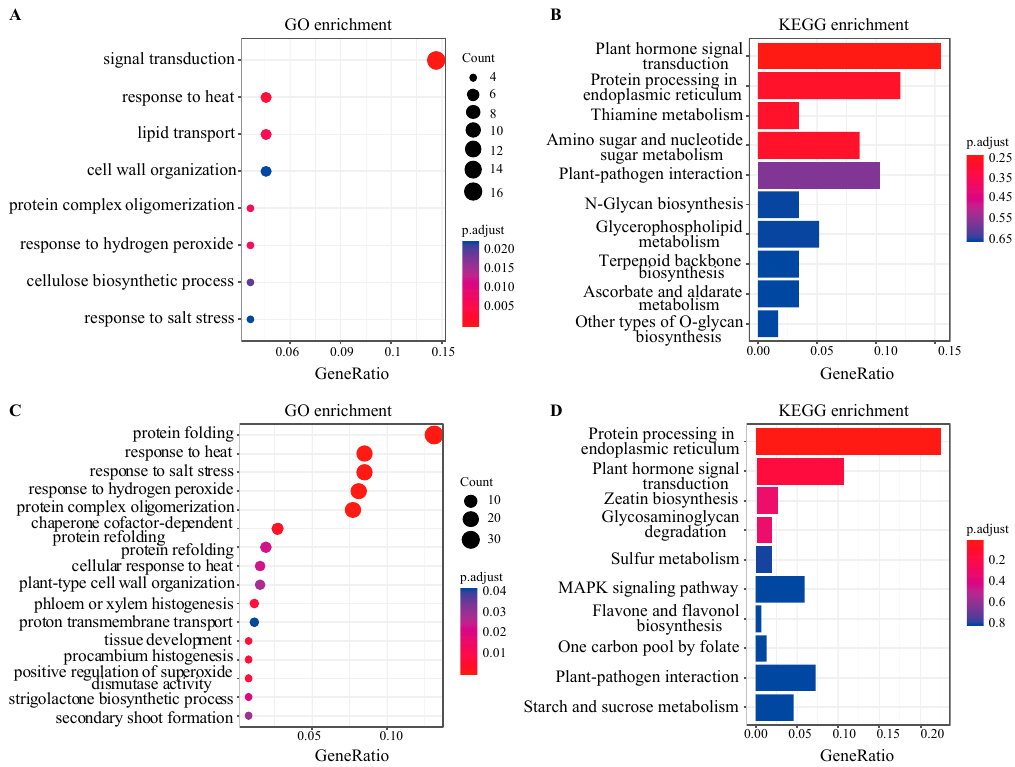
Figure 5. Enrichment analysis of module genes. ( A ) Gene ontology (GO) enrichment analysis of tan module. ( B ) Kyoto Encyclopedia of Genes and Genomes (KEGG) enrichment analysis of tan module. ( C ) GO enrichment analysis of green module. ( D ) KEGG enrichment analysis of green module.